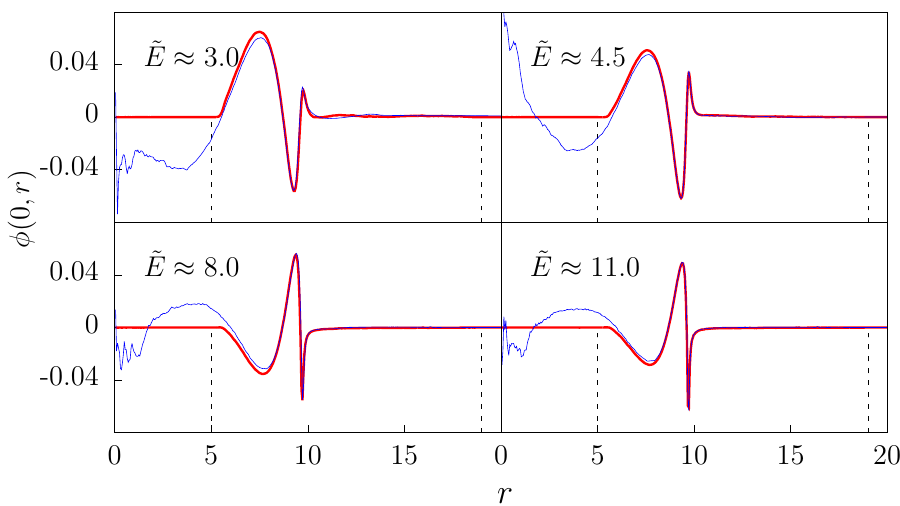
Figure 9 . The upper boundary initial (cid:12)eld con(cid:12)gurations of the solutions related by time-shift symmetry for ~ E (cid:25) 3 : 0 ; 4 : 5 ; 8 : 0 and 11.0. The space lattice parameters are N r = 400, R = 20. The dashed lines mark the space interval for the initial wave packet.